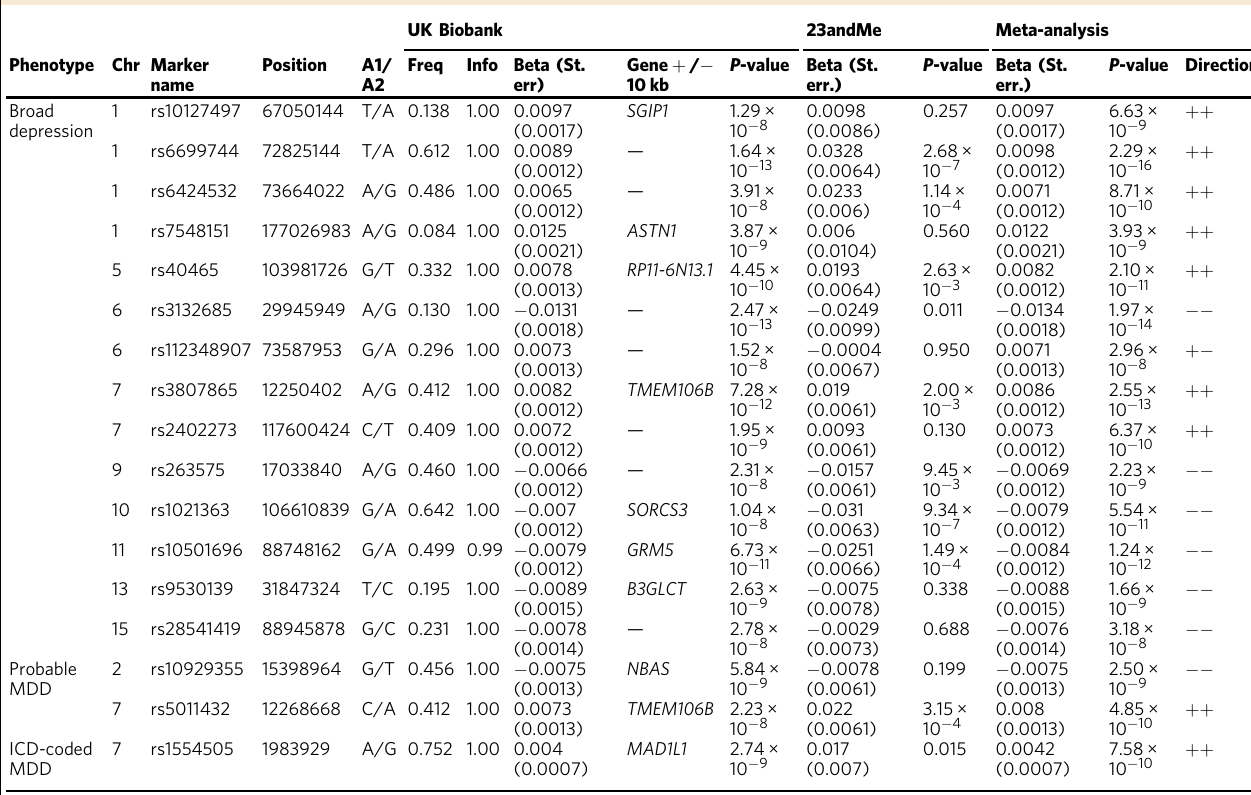
Table 1 Independent variants with a genome-wide signi fi cant ( P < 5 × 10 − 8 ) association with broad depression, probable major depressive disorder (MDD) or International Classi fi cation of Diseases (ICD)-coded MDD in UK Biobank UK